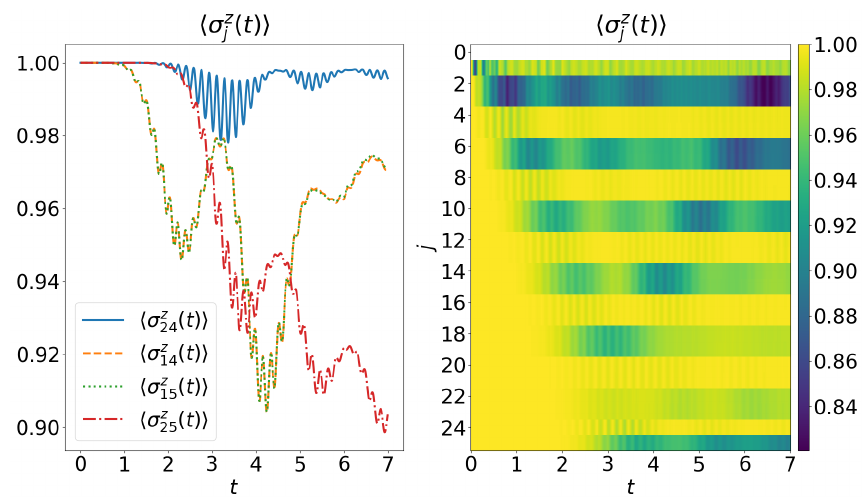
Figure 8: The Z Pauli expectation values vs. time for 26 qubits in a plaquette as in Fig. 7, for t ≤ 7. Time curves are given for 4 qubits (left panel), and a space-time diagram for the whole system (right panel). The color bar on the right associates the scale of colors to the expectation value of each qubit (with qubit 0 excluded for clarity), plotted in rows from j = 1 to j = 25. The qubits that have a higher lab = ∆ = 2 π × 5) remain close to the ground state, while the ones frequency (with h z , i = 0) develop a somewhat lower 〈 Z 〉 value. with a lower lab frequency (with h z , i Two superimposed oscillation timescales are clearly visible, and pairs of qubits in the upper and lower arms of the plaquette (e.g., 14 and 15), evolve identically by symmetry – see the text for a detailed